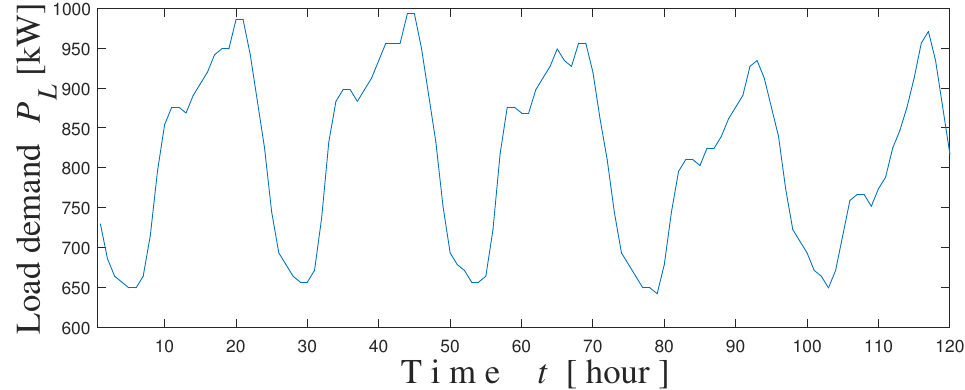
Figure 3. Hourly electrical energy demand.